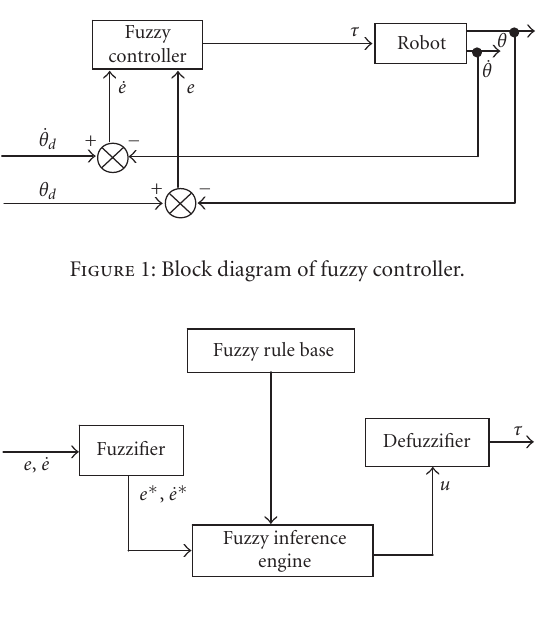
Figure 2: Details of fuzzy controller block.